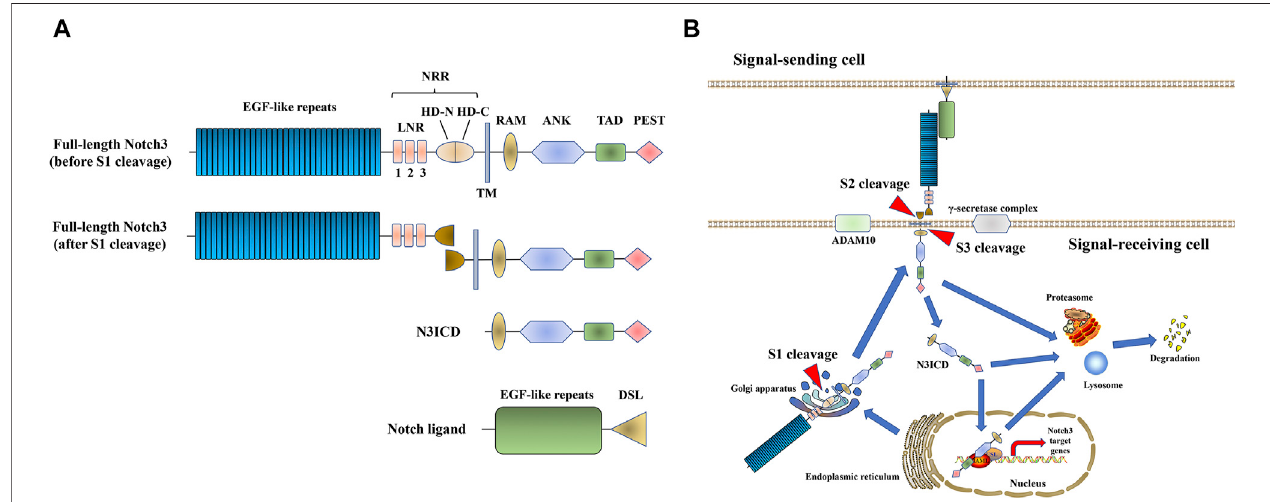
FIGURE 1 | Notch3 signaling. (A) The structure of Notch3 and its ligand. The full-length Notch3 protein consists of 34 epidermal growth factor (EGF) repeats, a negativeregulatory region(NRR) [composedofthree Lin-Notch repeats (LNRs)and aheterodimerizationdomain (HD)], atransmembranedomain, an RBPJ-association module (RAM) domain, seven ankyrin (ANK) repeats, two nuclear localization signals (NLS), a transactivation domain (TAD) and a C-terminal domain rich in proline, glutamic acid, serine, and threonine (PEST domain) (Xiu and Liu, 2019). The Notch ligand consists of EGF repeats and a Delta/Serrate/LAG-2 (DSL) domain. (B) Notch3 signal transduction